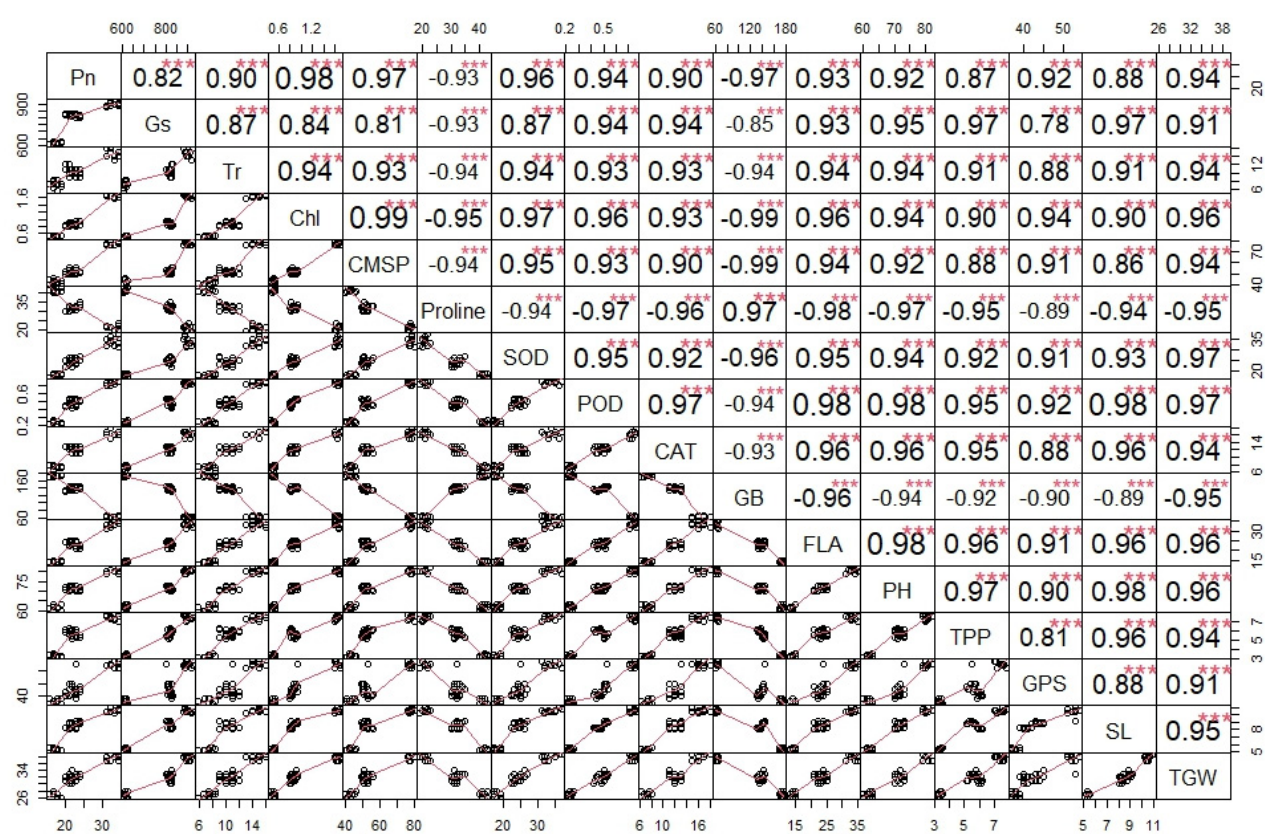
Figure 1. Correlation chart showing the significance of association of physiological, biochemical, and agronomic traits in synthetic hexaploid wheat genotypes. Pn; photosynthesis, Gs; stomatal conductance, Tr; transpiration rate, CMSP; cell membrane stability percentage, GB; glycine betaine, SOD; superoxide dismutase, POD; peroxidase, CAT; catalase, FLA; flag leaf area, PH; plant height, TPP; tiller per plant, SL; spike length, GPS; grains per spike, TGW; thousand grain weight. *** = significant at p ≤ 0.001 .